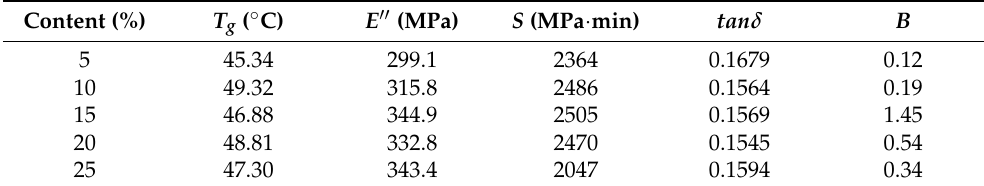
Table 3. Dynamic thermo-mechanical parameters of core–shell structured